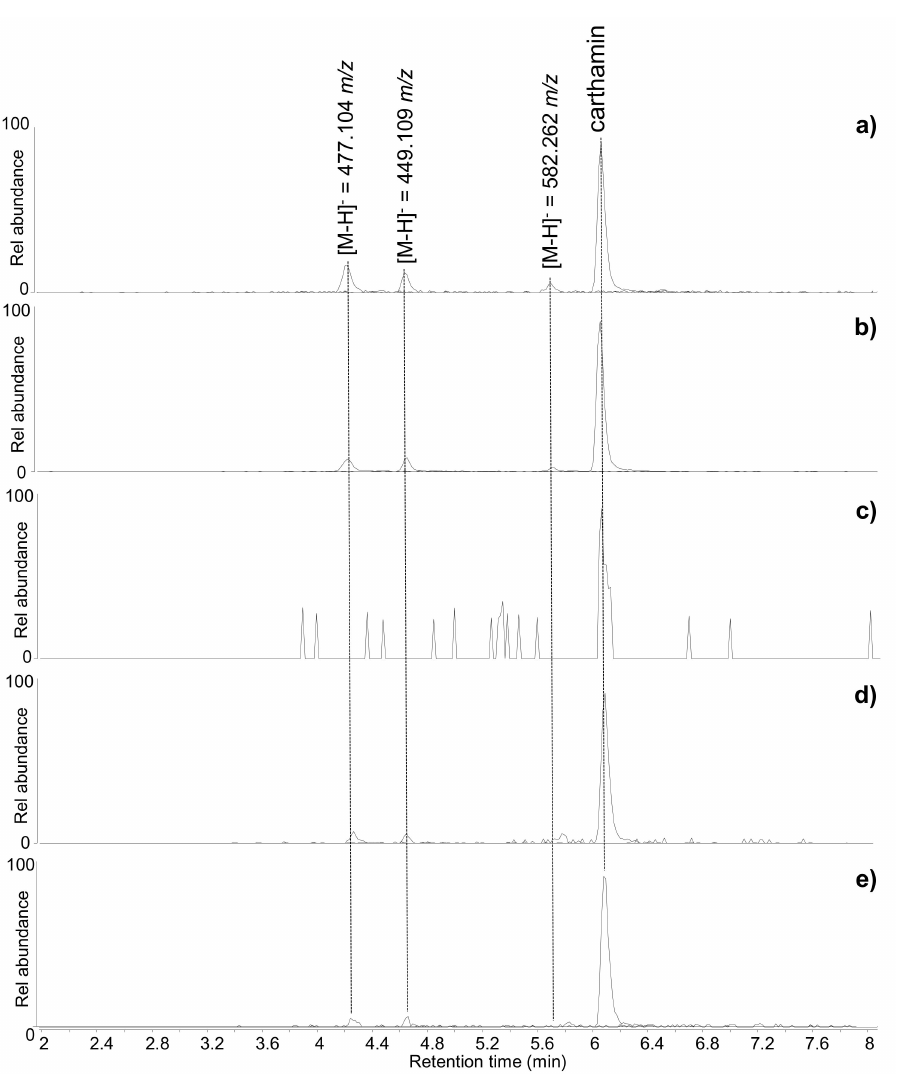
Figure4. Extractionchromatogramsofthemolecularcomponentsofsa ffl ower( C.tinctorius